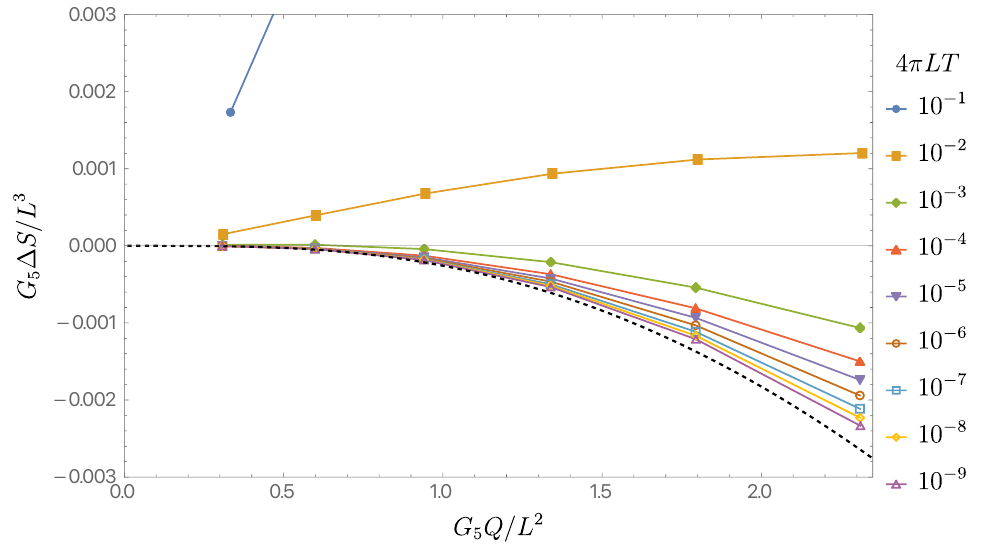
Figure 11 . ∆ S as a function of Q computed for several fixed temperatures shown on the figure caption on the right. The black dashed line shows the entropy appearing in figure 4 for the T = 0 near horizon geometry (for charges up to G 5 Q/L 2 ∼ 2